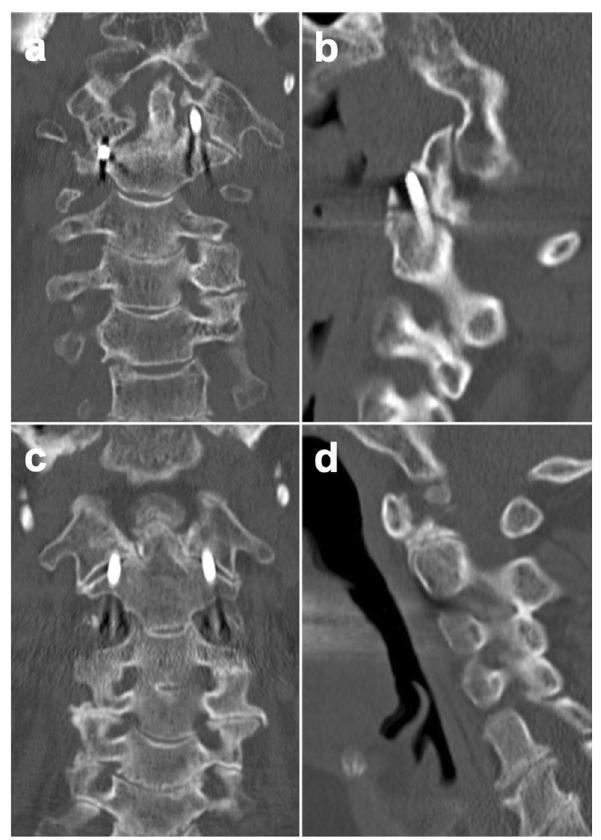
Figure 1. Material loosening versus spinal fusion. This figure shows the radiological outcome of two patients on computed tomography (CT) > 120 d postoperatively. ( a ) Patient 1 coronal plane: In the cranial region of the left- sided transarticular inserted screw, a clear lysis zone can be seen within the lateral mass of C1 as a correlate of material loosening. ( b ) Patient 1 sagittal plane: Also, in the sagittal plane, the loosening of the screw in the left- sided lateral mass of C1 can be clearly traced. ( c ) Patient 2 coronal plane: In this patient, no material loosening can be identified in the coronal plane. In the area of the right-sided joint space of C1/C2, a bony fusion can be identified. ( d ) Patient 2 sagittal plane: Here, too, the bony fusion between C1 and C2 can be